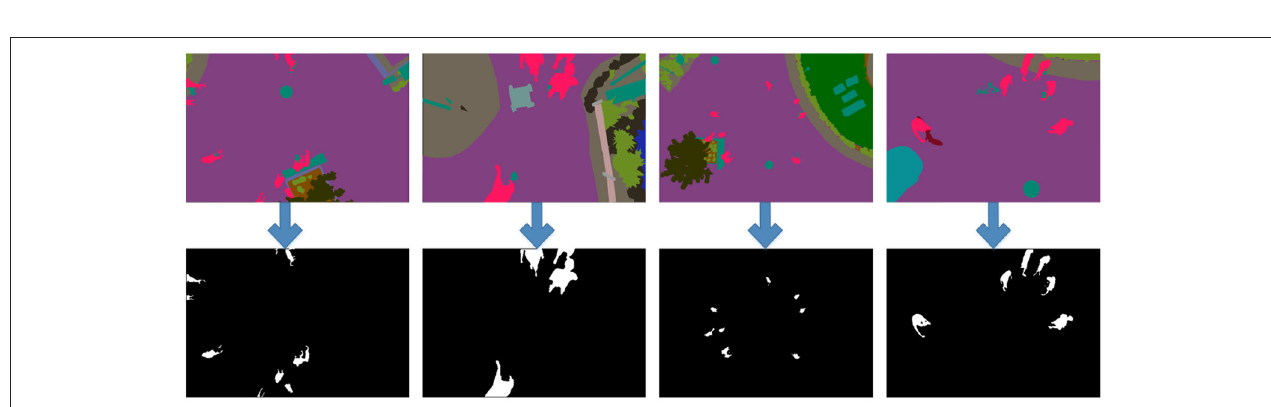
FIGURE 8 | Conversion of 20-classes semantic mask images to 2- classes (The number of classes has been reduced to 2 since our study aimed to only recognize human and non-human pixels).